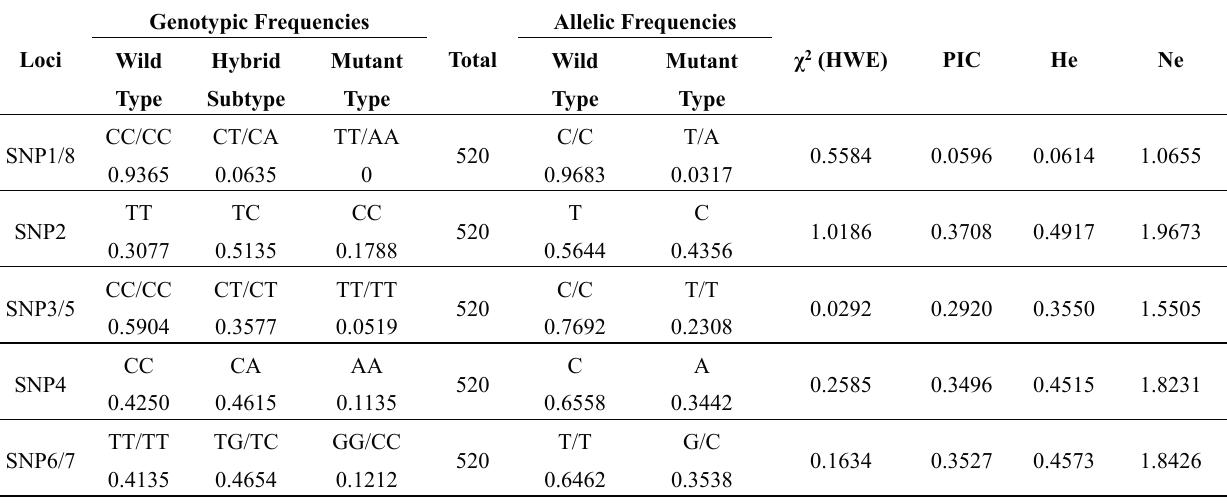
Table 1. Genotypic, allelic frequencies and genetic diversity of eight SNP loci within the SMO gene in Qinchuan cattle populations.